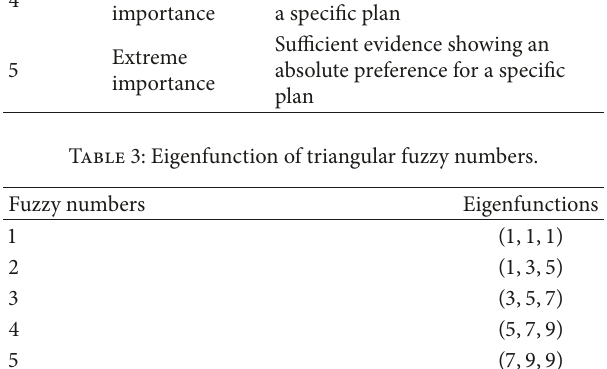
Figure 2: Intersection graph of fuzzy numbers